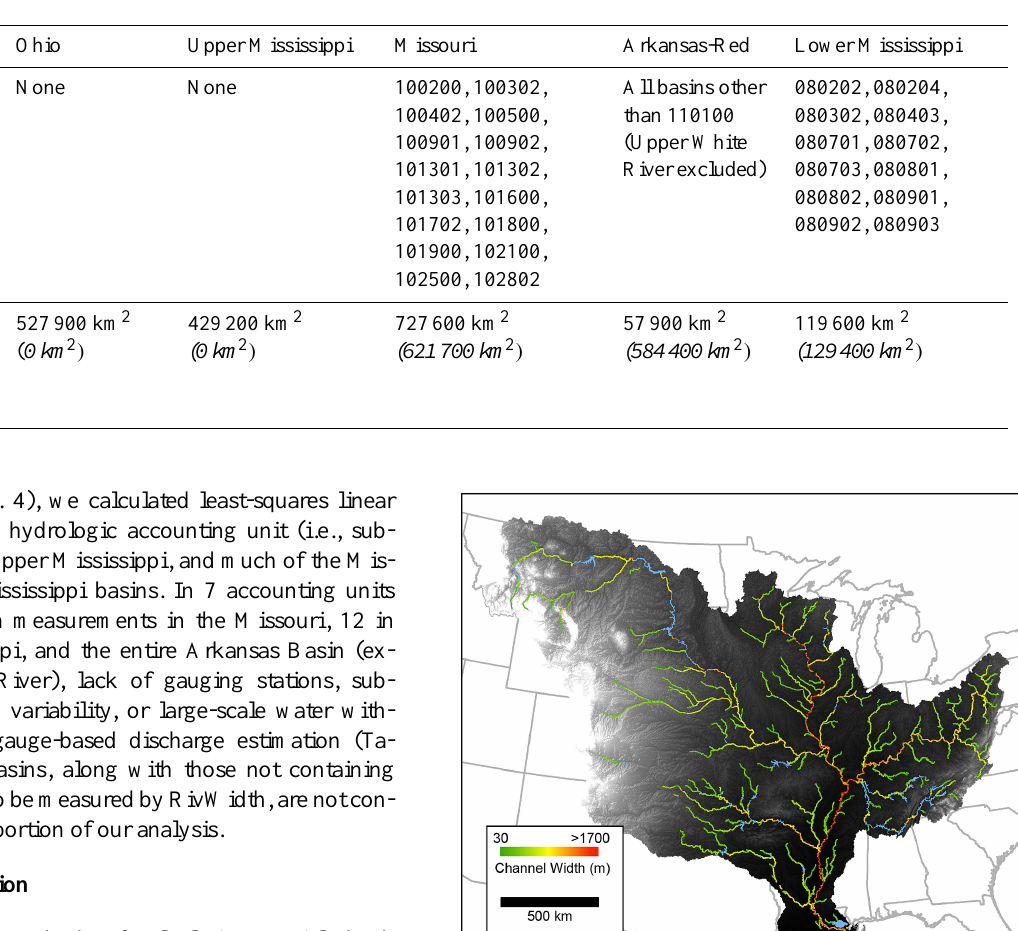
Table 1. Portions of the Mississippi Basin included in and excluded from the analysis.